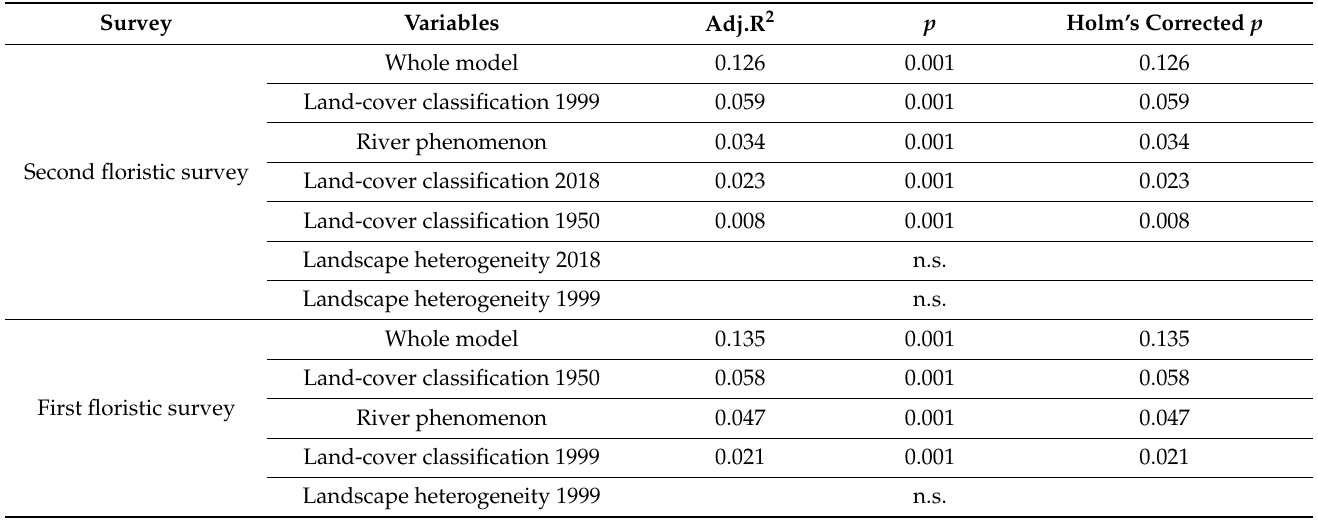
Table 2. Variables tested in the distance-based redundancy analysis (db-RDA; Sörensen dissimilarity, Hellinger distance; geological diversity filtered as a covariate), assessed the variation of the whole model and then tested using forward selection with an adjusted R 2 and Holm’s correction. n.s.—not significant.